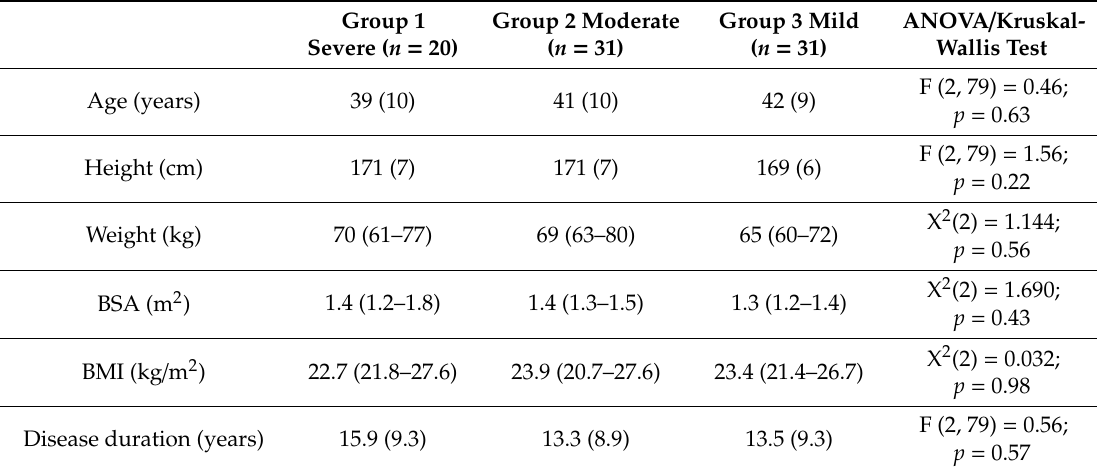
Table 2. Baseline criteria for female ME / CFS